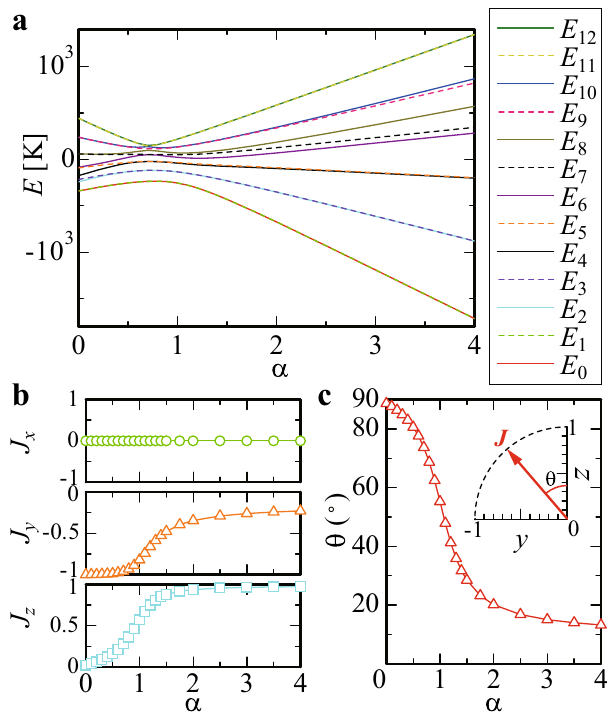
Figure 2. Crystalline-electric-field energies and magnetic-moment direction of the ground state. ( a ), The α α Z Au . ( b ), The α dependence of the largest-moment direction of dependence of the CEF energies at Tb in Z Si = the CEF ground state shown by the normalized vector J . (top panel) J x versus α , (middle panel) J y versus α , and (bottom panel) J z versus α . ( c ), The α dependence of θ defined by the angle of J from the z axis in Fig. 1f. Inset illustrates the J vector in the yz plane. (This figure is created by using Adobe Illustrator CS5 Version